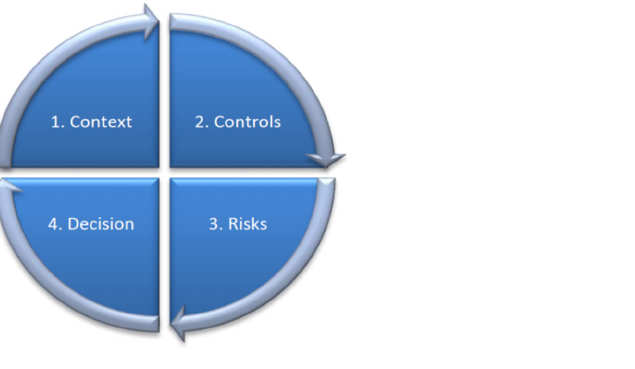
Figure 1. General approach of the privacy impact assessment, Commission Nationale de l’Informatique et des Libertés (PIA-CNIL)